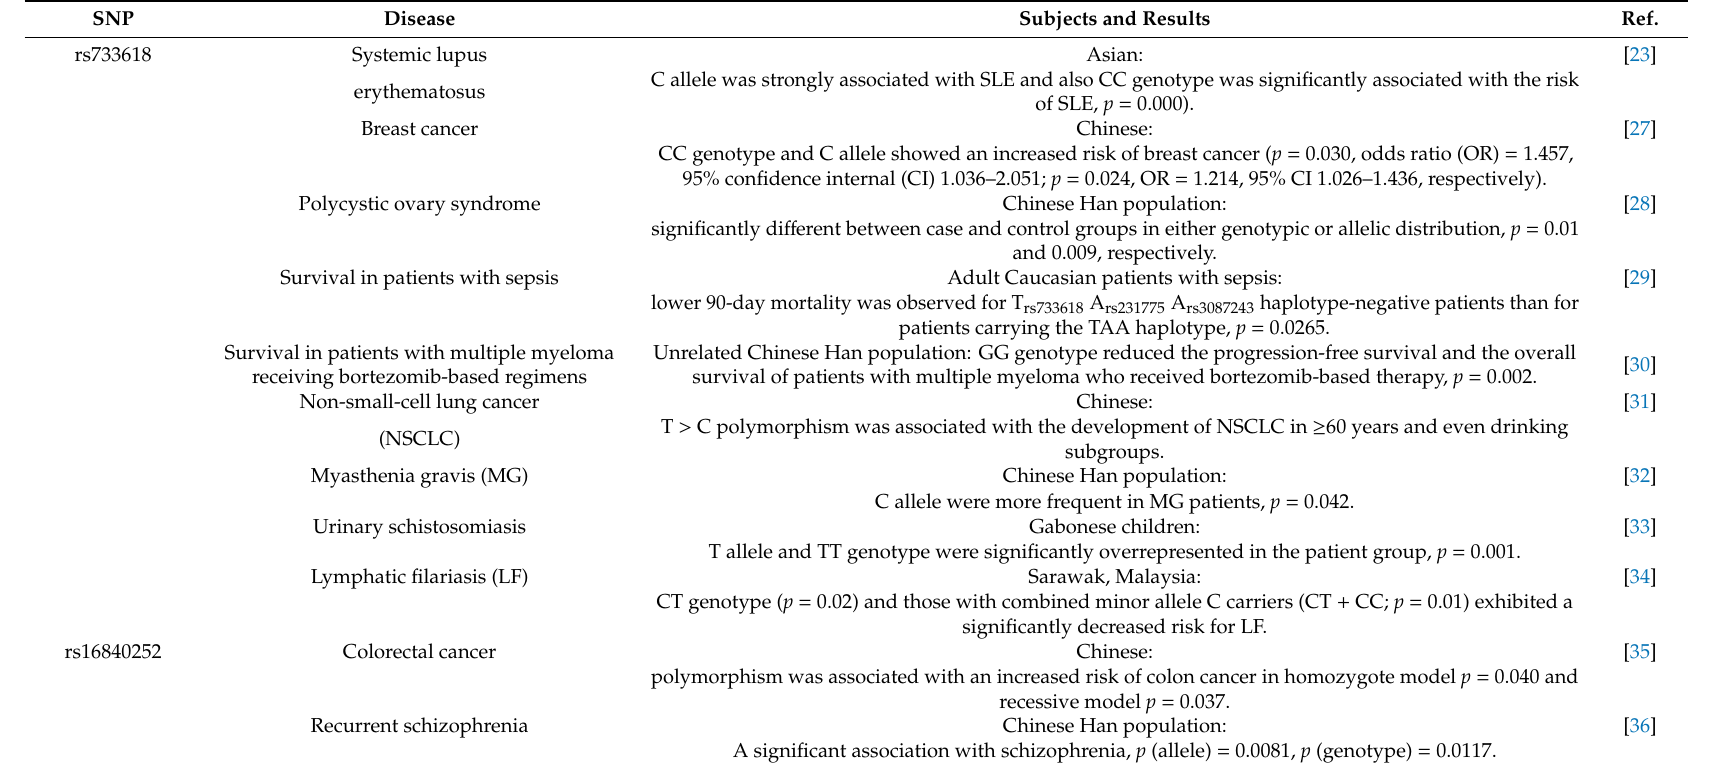
Table 6. Summary of rs733618 and rs16840252-related